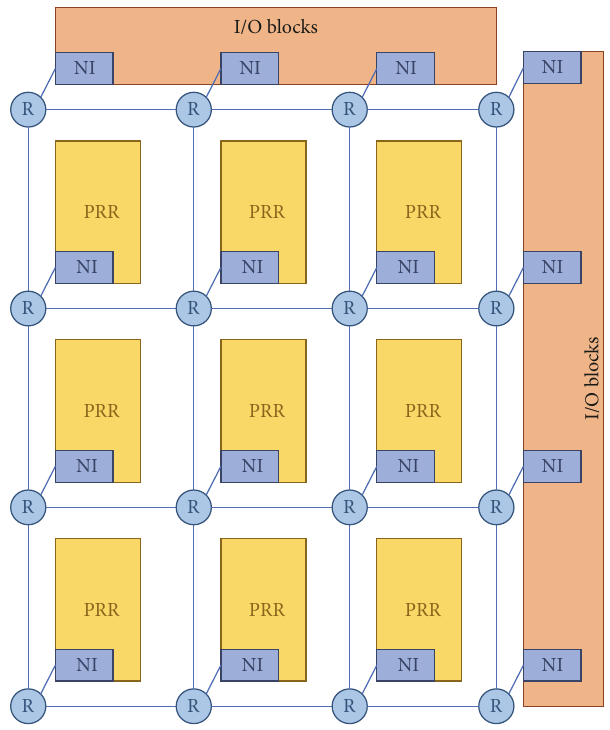
Figure 2: A typical NoC based architecture for FPGA virtualization.